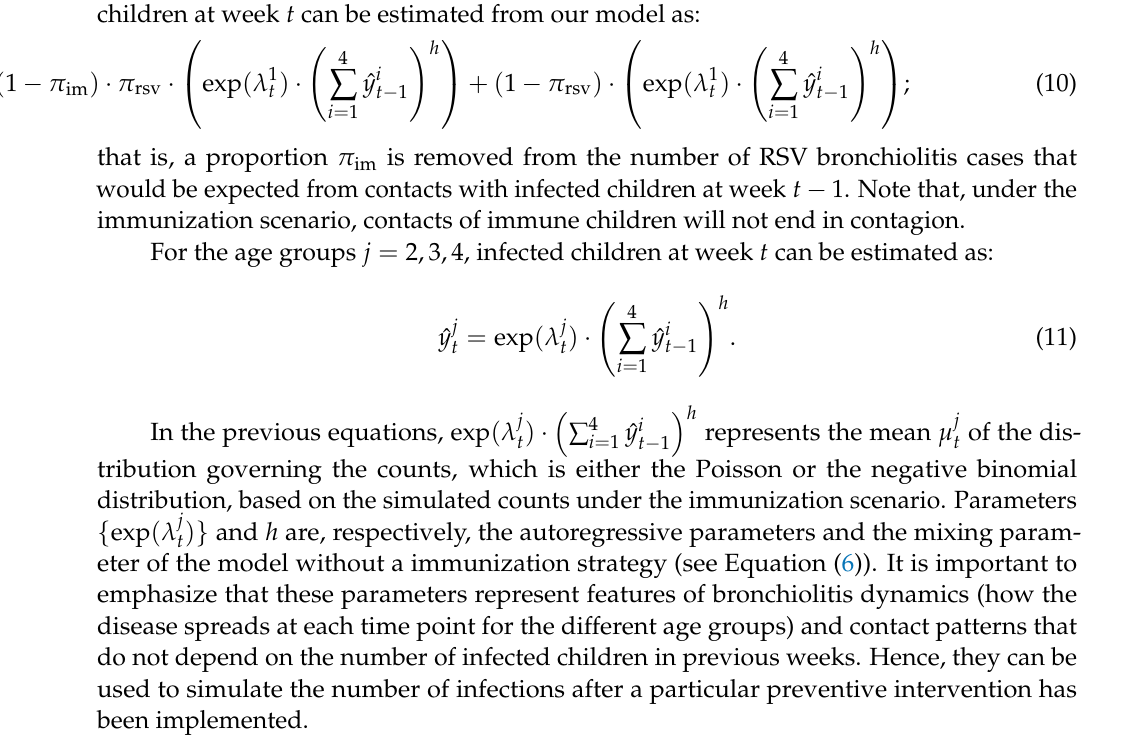
Table 1. Possible scenarios in the evaluation of immunization strategies. Maternal Vaccination mAb at Birth Uptake Efficacy % Removed Uptake Efficacy % Removed 50% 40% 20% 95% 70% 66.50% 85% 40%